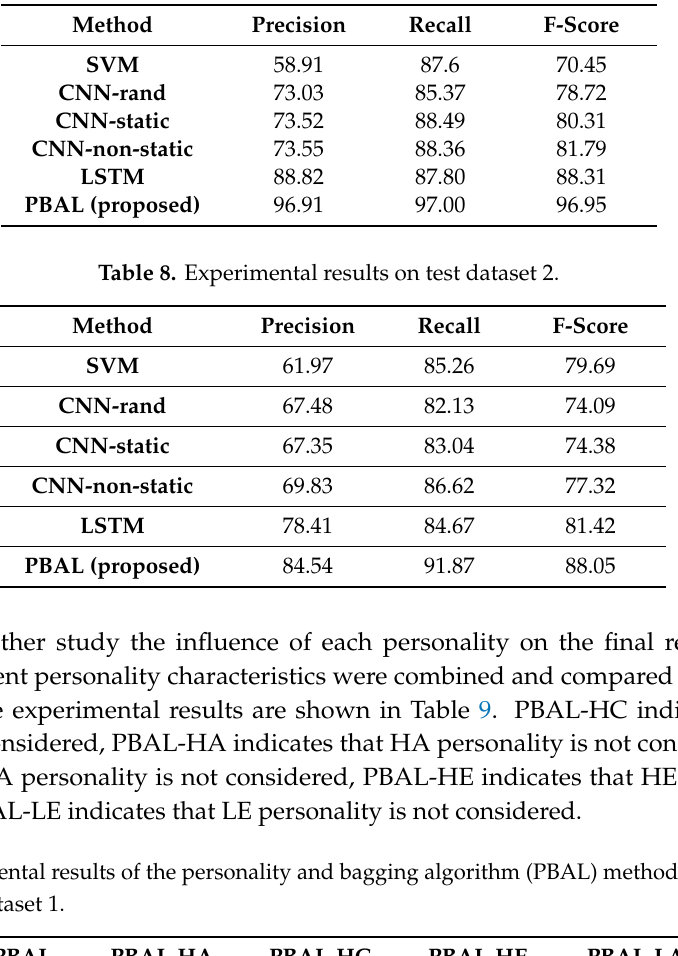
Table 7. Experimental results on test dataset 1.